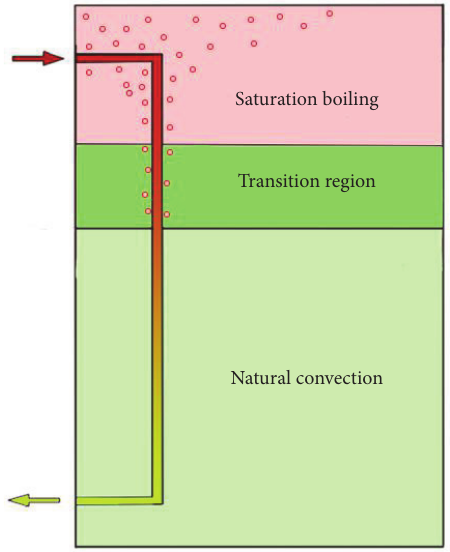
Figure 6: Schematic diagram of heat transfer mechanism.